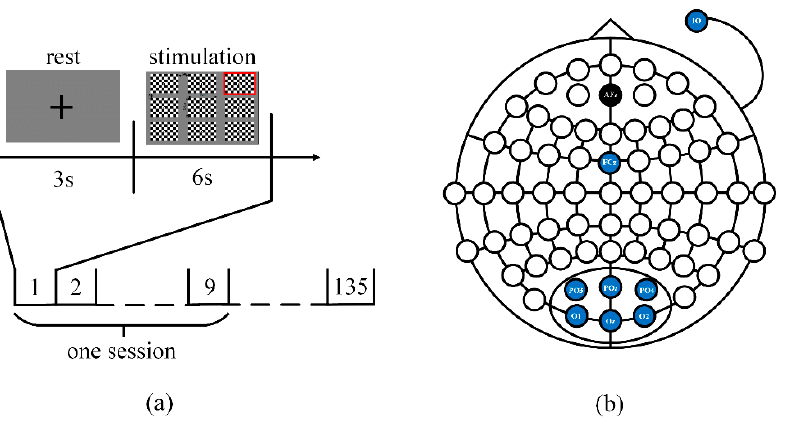
Figure 1. Experimental configuration of the SSVEP experiment, including ( a ) experimental protocol, and ( b ) channel configuration for data acquisition.